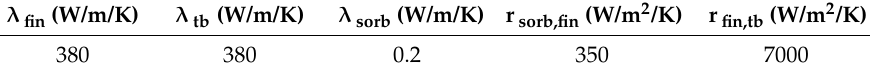
Table 4. Heat conductivity parameters of the heat exchanger.